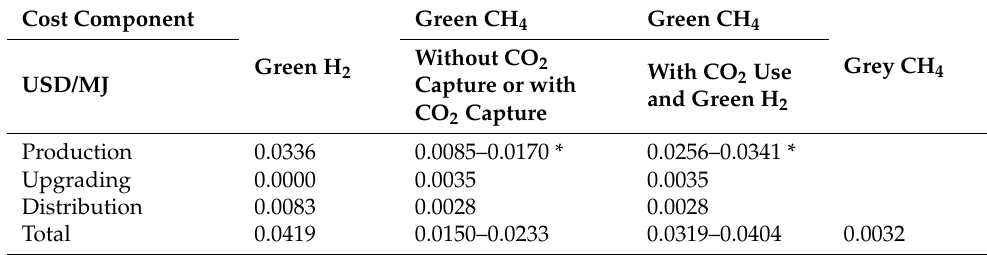
Table 3. Cost comparison of green hydrogen from wind power, of green methane (biomethane) with or without CO 2 capture, of green methane augmented with and without CO 2 capture in the biogas and of grey methane (fossil) as the